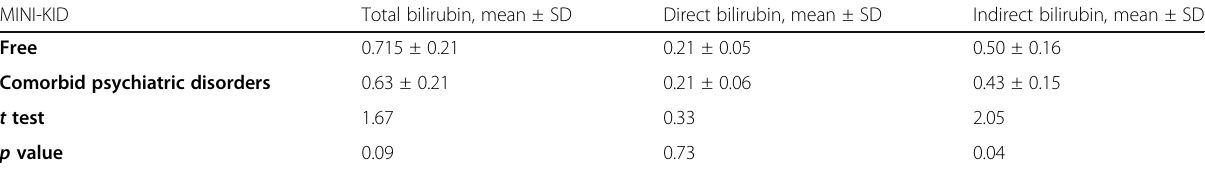
Table 3 The relationship between serum bilirubin concentration and psychiatric comorbidity MINI-KID